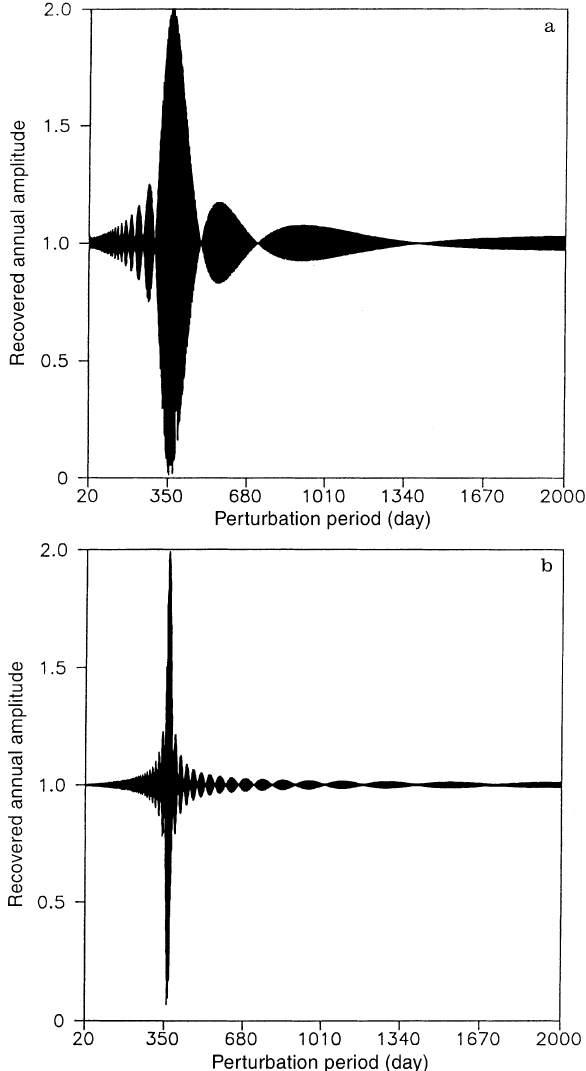
Fig. 4. a As Fig. 2b, but for a simulation duration of 4 years; b Same as Fig. 2b, but for a simulation duration of 20 years under the sampling scheme of TOPEX/POSEIDON